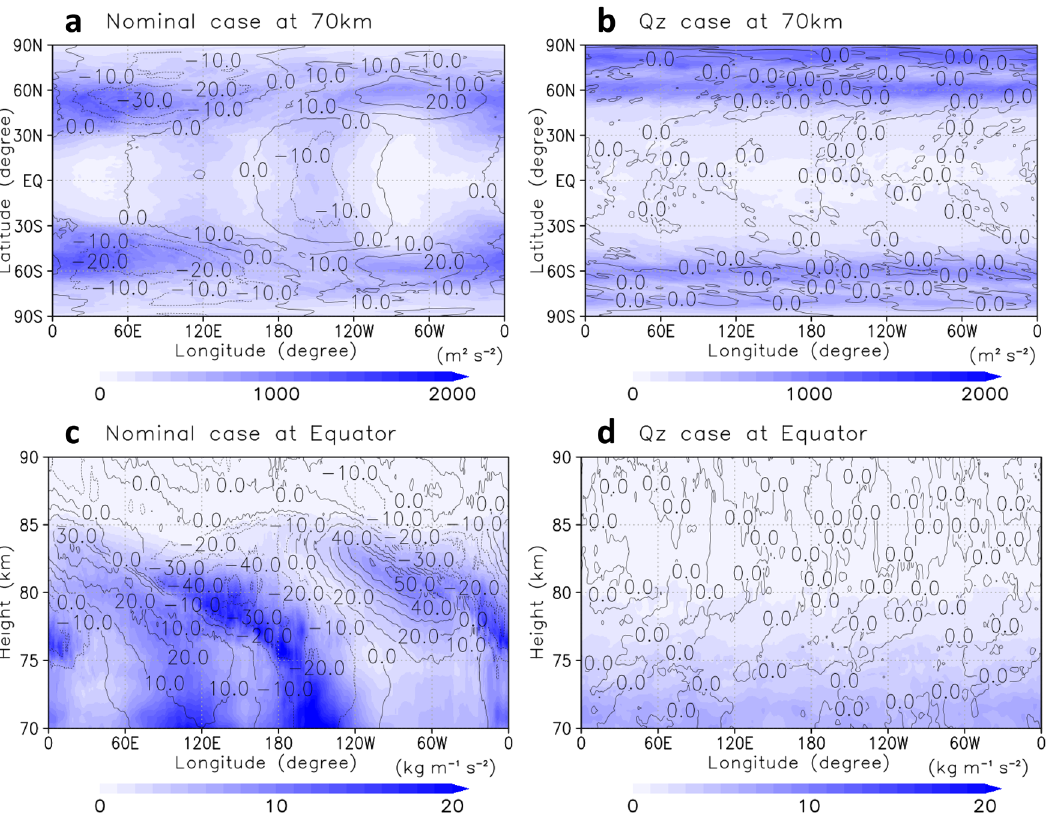
Fig. 2 Total wave-energy (TWE). a , b Longitude – latitude cross-sections of TWE (sum of eddy kinetic energy E k and potential energy E p ; colour shade, m 2 s − 2 ) at the cloud-top (~70 km) level for the nominal and Qz cases, respectively. c , d Longitude – height cross-sections of density weighted TWE at the equator (sum of ρ E k and ρ E p ; colour shade, kg m − 1 s − 2 ) for the nominal and Qz cases, respectively. TWE has been averaged over 30 Earth days in a solar- fi xed reference frame (i.e., composite-mean). Deviations of zonal fl ow from its zonal average (black contours; intervals are 10 m s − 1 ) are also shown. The subsolar point is located at the centre of panels, (180°E, 0°N), for a and c